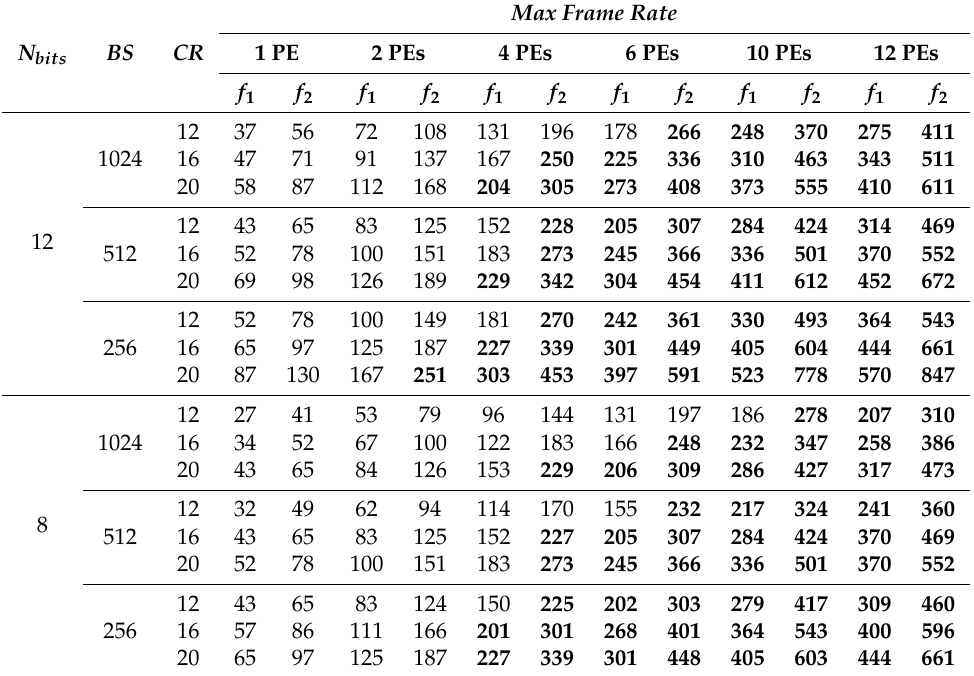
programmable SoC for hyperspectral images with 180